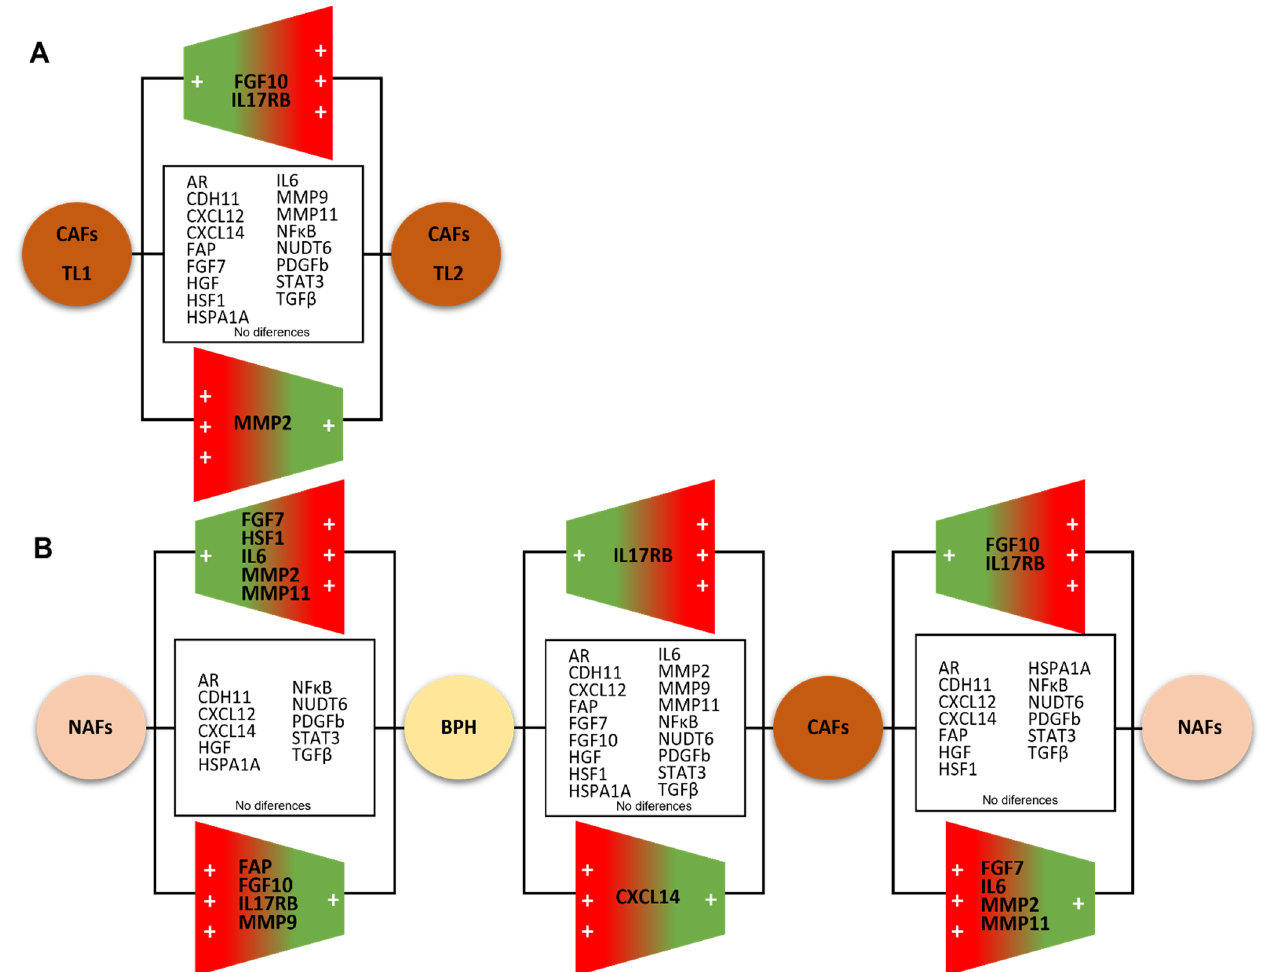
Figure 7. Scheme summarizing the comparative analysis of gene expression of stromal factors among ( A ) CAFs from main tumor location (TL1) and secondary tumor focus (TL2); ( B ) NAFs and CAFs from prostate carcinomas and fibroblasts from benign prostatic hyperplasia (BPH). The upregulation (red), downregulation (green), or non ‐ changed factors for each factor in each comparison are shown.